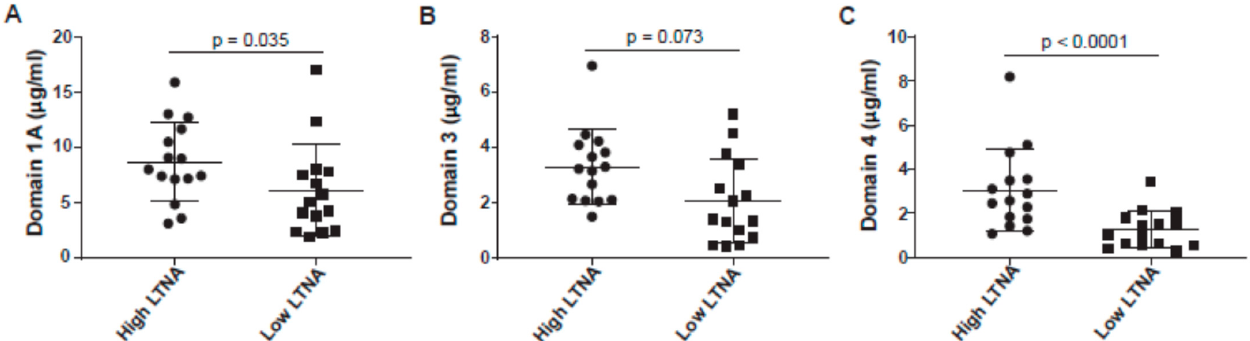
Figure 5. Anti-PA domain specificity by recombinant domain ELISA. ( A ) Anti-domain 1A and ( B ) anti-domain 3 concentrations show slightly significant or non-significant differences in concentration between high and low neutralizers, respectively. ( C ) The anti-domain 4 concentration difference is strongly significant with low neutralizers making less anti-domain 4 antibody. Data from high neutralizers are shown as circles; data from low neutralizers are shown as squares.